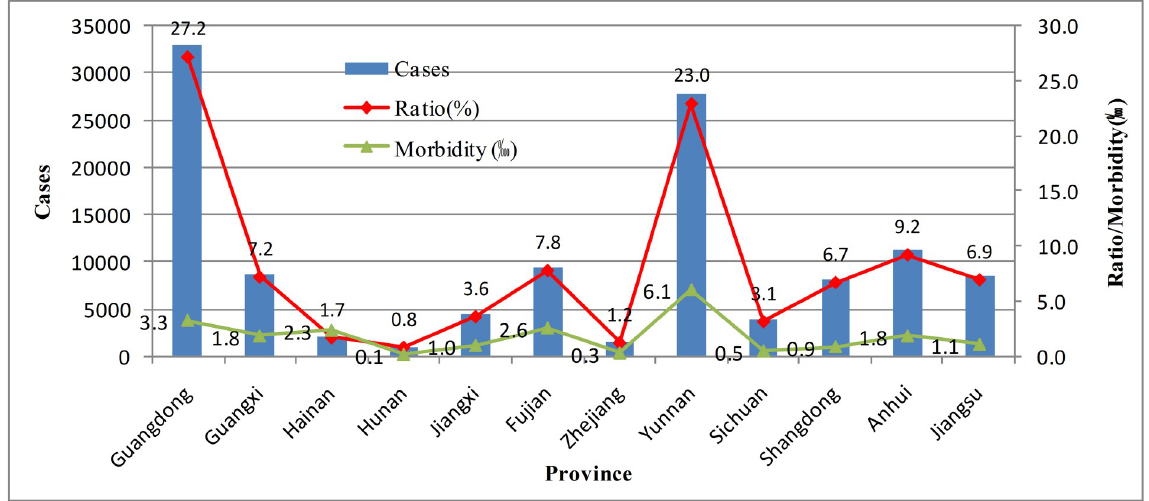
Fig 7. Scrub typhus cases, the case ratio and the morbidity in key regions in 12